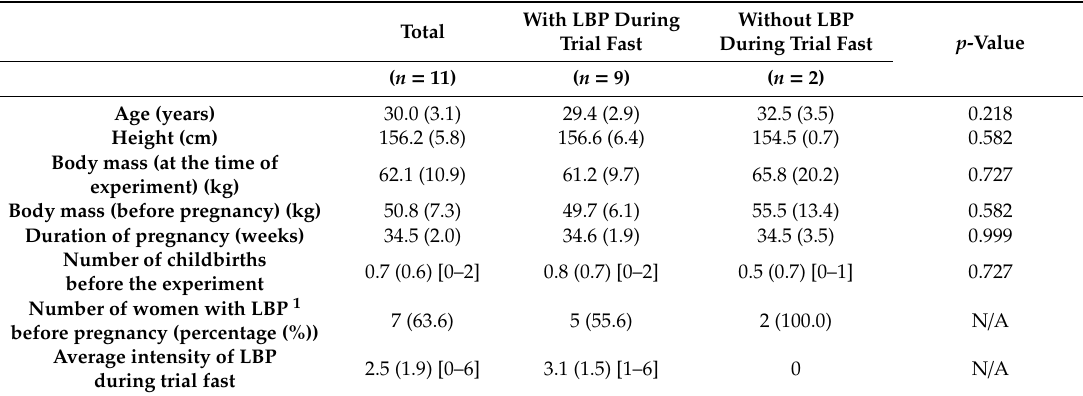
Table 1. Personal characteristics of the study participants. With LBP During Total Trial